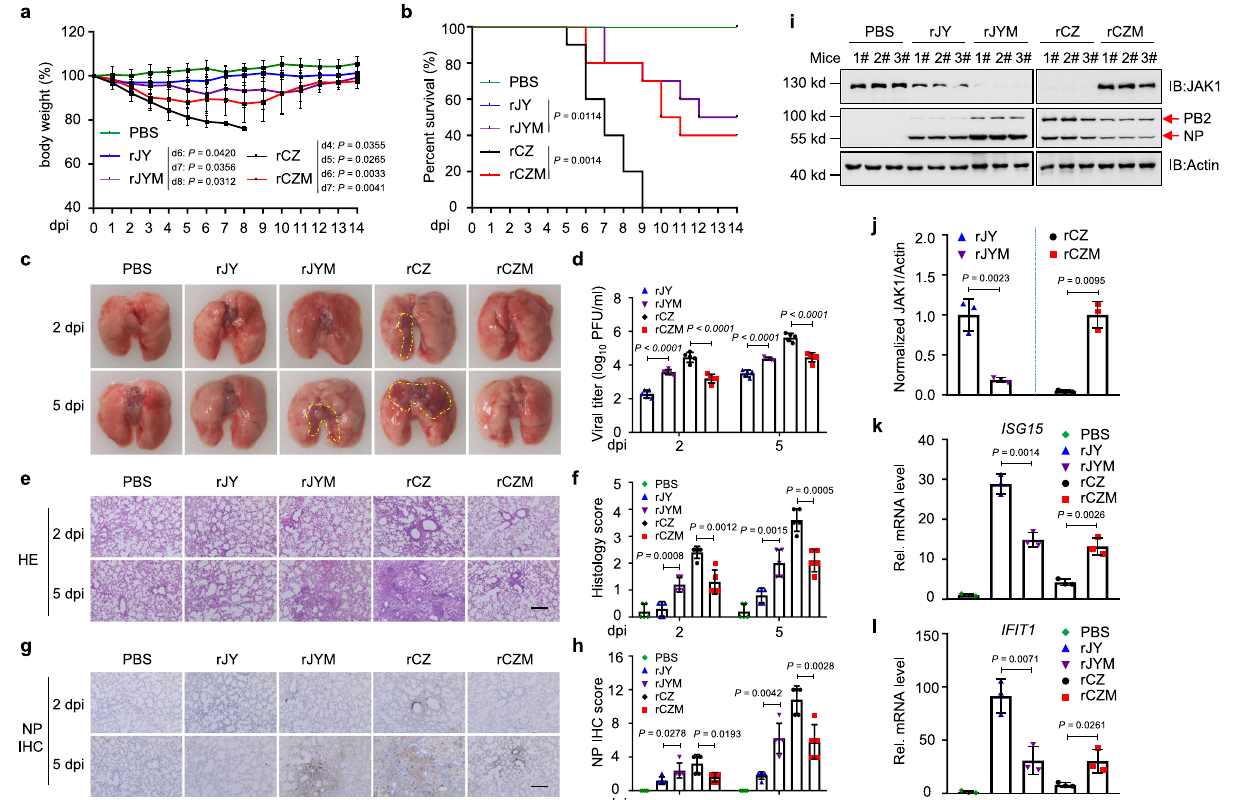
Fig. 10 | JAK1 degradation mediated by AIV PB2 signi fi cantly increases the virulence of AIV in mice. a , b The mice ( n =10 per group) were intranasally inoculated(10 6 EID 50 permouse) withrJY,rJYM, rCZ,orrCZMvirusand monitored for 14 d for body weight loss ( a ) and survival ( b ). c Gloss lesions of lungs from the infected mice on 2 and 5 dpi. Severe pneumonia with diffuse consolidation was outlined in yellow. The images are from representative one of fi ve mice. d Viral titersinthelungs(n=5pergroup)weredeterminedon2and5dpibyplaqueassay. e – h Hematoxylin/eosin (HE) staining ( e ) and scoring ( f ), immunohistochemistry